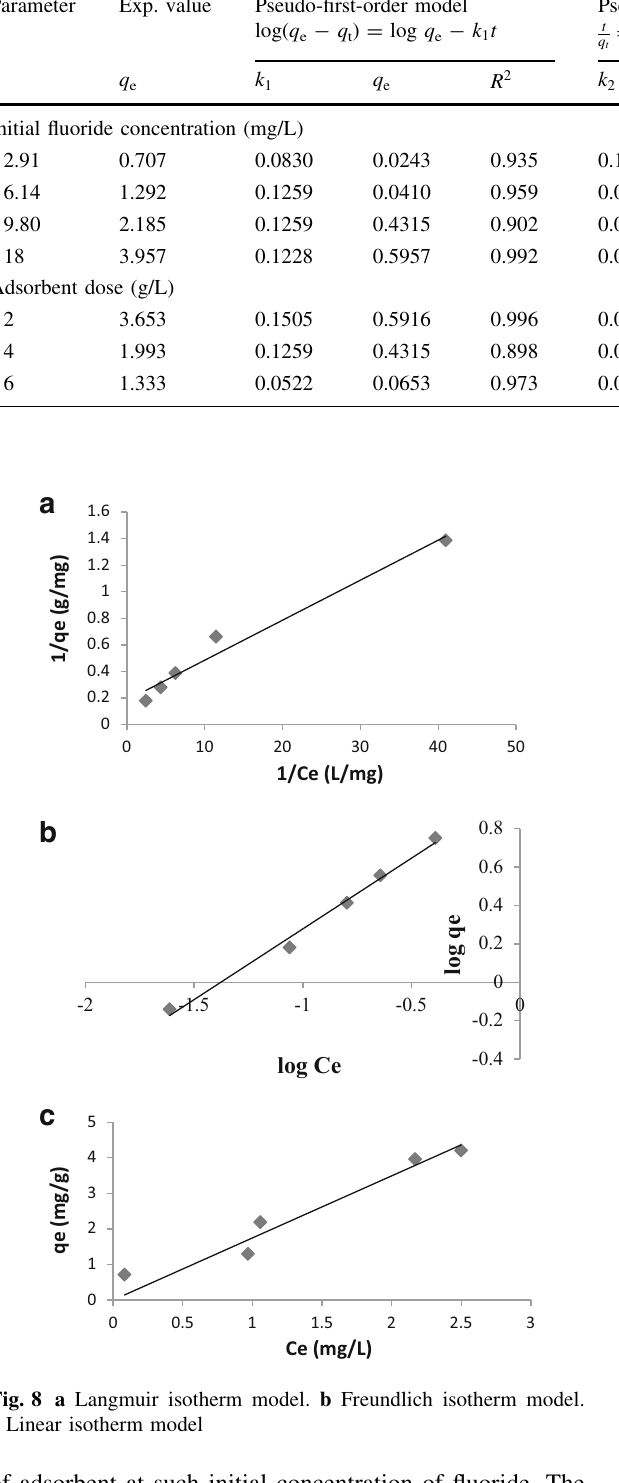
Table 5 Values of kinetic parameters Parameter Exp.